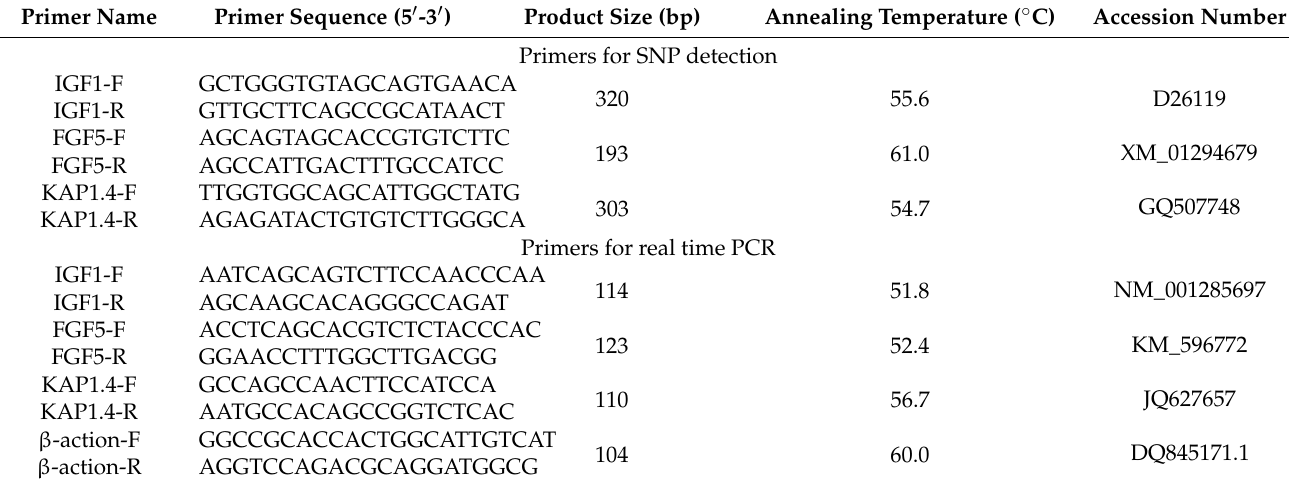
Table 1. Primer sequences for PCR and real-time